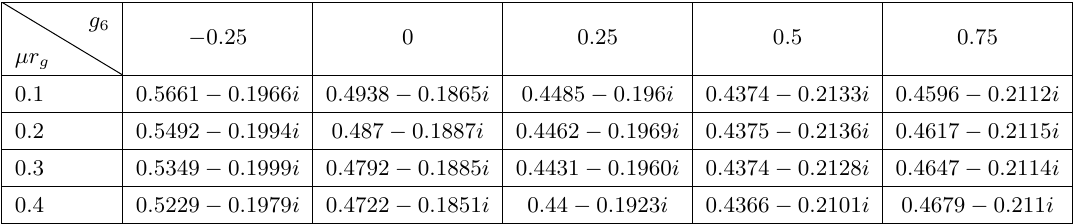
Table 5 . Frequencies ωr g of the fundamental ( n = 0) , first multipole ( ‘ = 1) polar (vector)